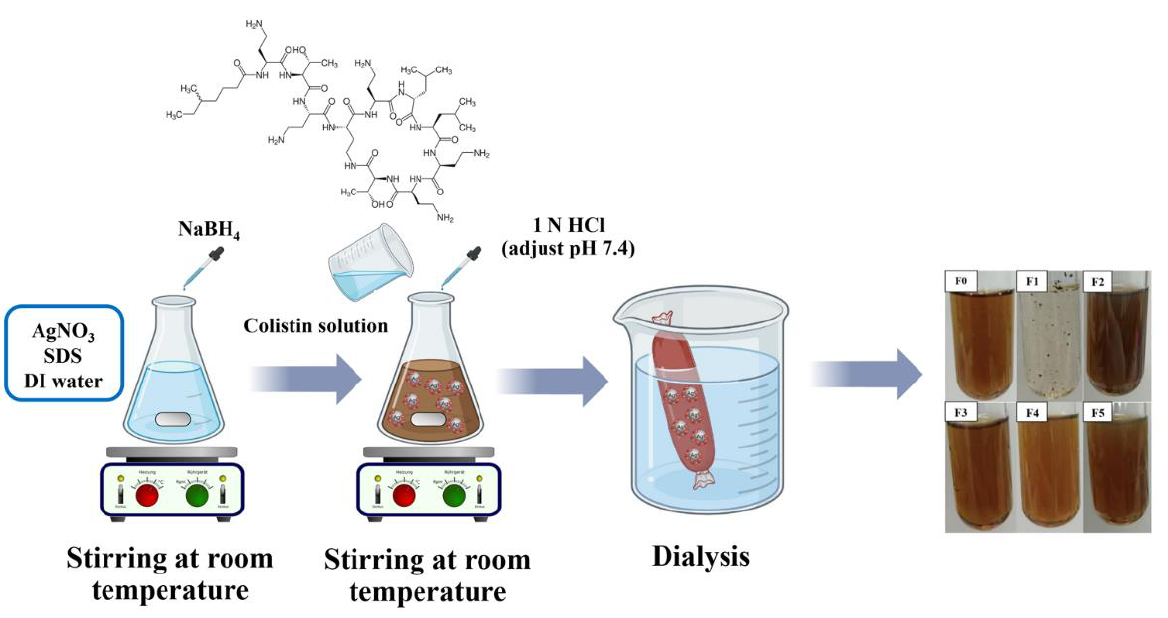
Figure 12. Schematic diagram of the synthesis of colistin - conjugated silver nanoparticles ( Col - AgNPs ).